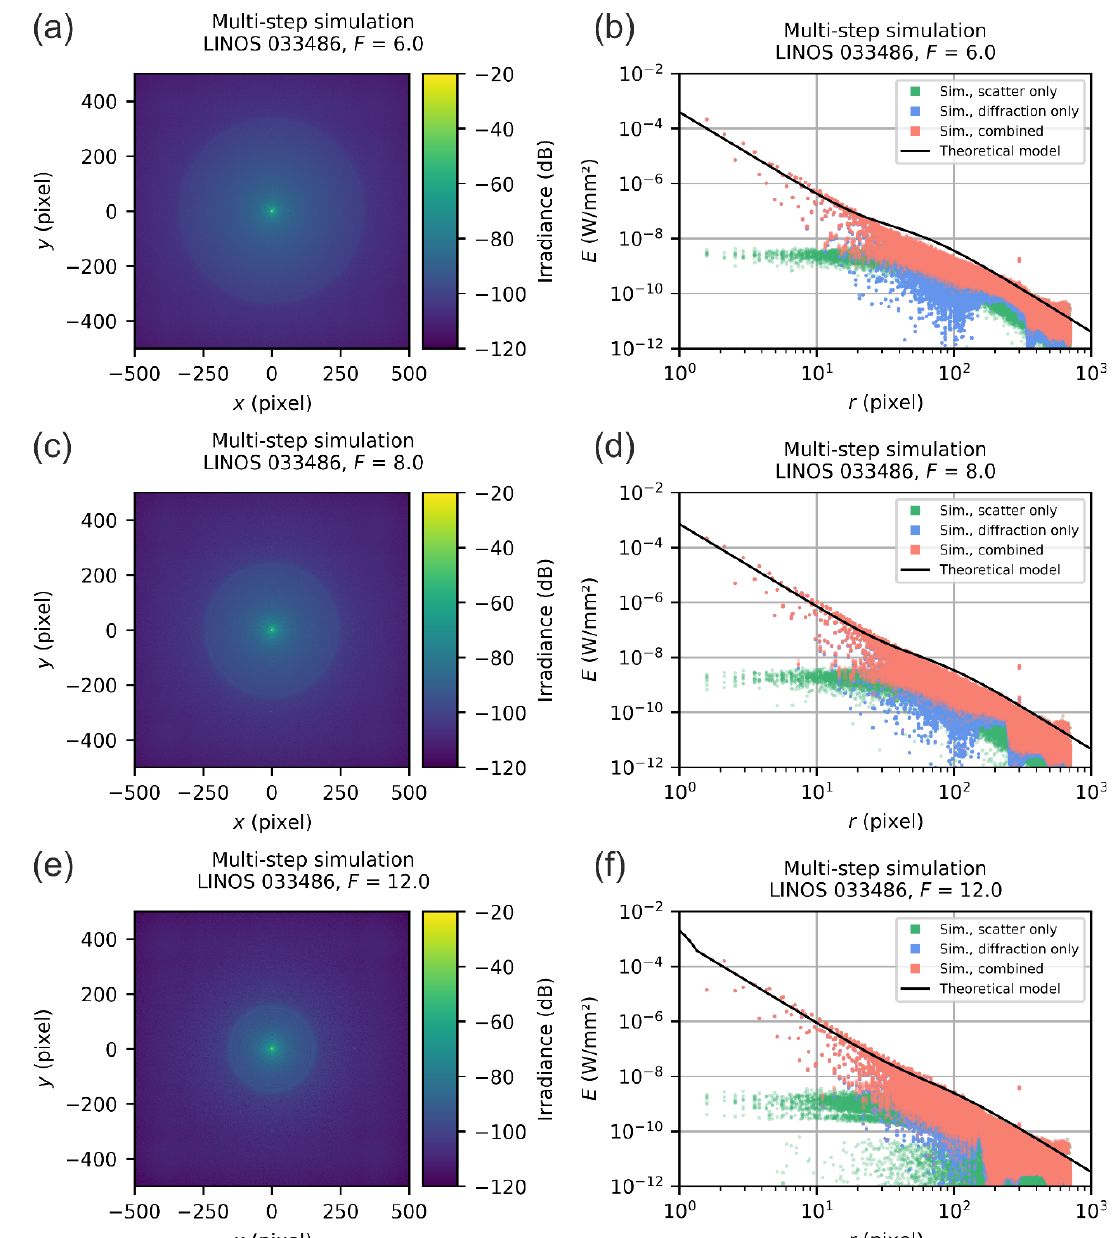
Figure 14. Results of the multi-step simulation for the LINOS 033486 laser focusing optics for the f-numbers of 𝐹 = 6.0 , 𝐹 = 8.0 and 𝐹 = 12.0 . ( a , c , e ) Results represented as an image. ( b , d , f ) Results f-numbers of F = 6.0, F = 8.0 and F = 12.0. ( a , c , e ) Results represented as an image. ( b , d , f ) Results shown as a scatter plot. shown as a scatter